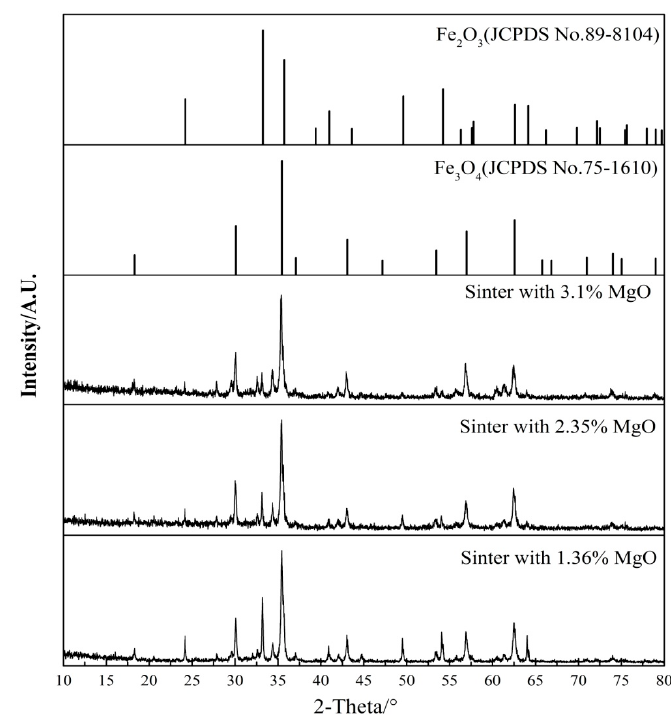
Figure 6. XRD patterns of sinter with different content of MgO.